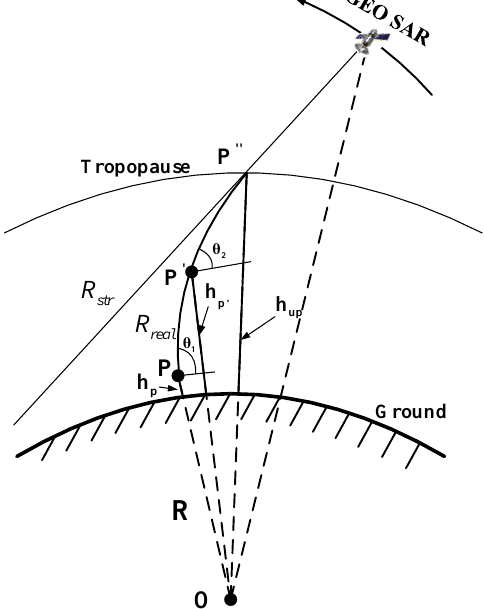
Figure 1. Sketch map of geosynchronous orbit synthetic aperture radar (GEO SAR) signal propagation in the troposphere.